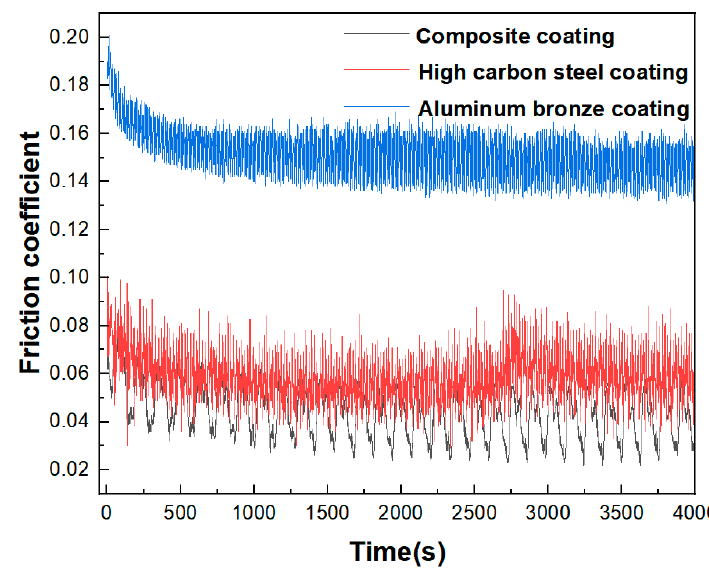
Figure 14. Diagram of friction coefficient with time under the load of 200 N.